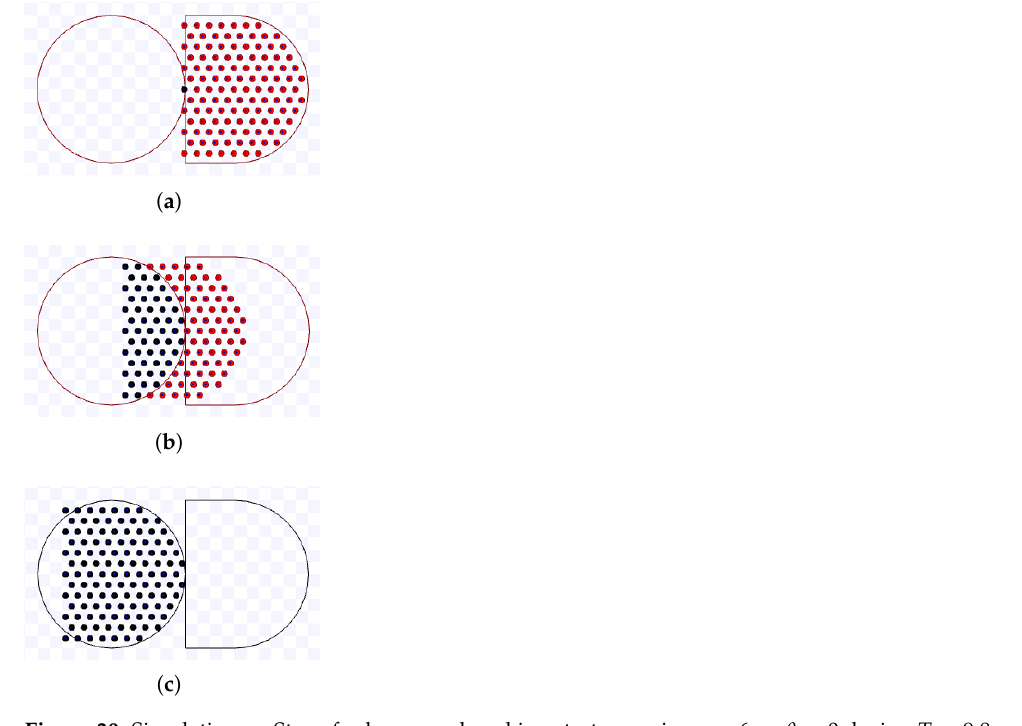
Figure 30. Simulation on Stage for hexagonal packing strategy using s = 6 m, θ = 0 during T = 9.8 s. Available on https://youtu.be/v0FK8YpGrL8, accessed on 12 June 2022. ( a ) 0 s: beginning of the simulation; ( b ) After 4.9 s; ( c ) 9.8 s: ending of the simulation.